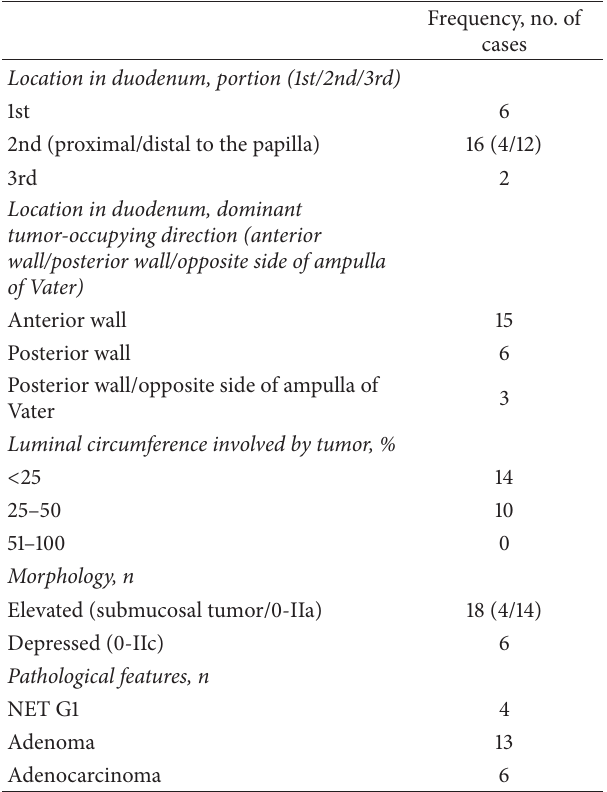
Table2:Clinicopathologicalcharacteristicsofduodenalneoplasms.